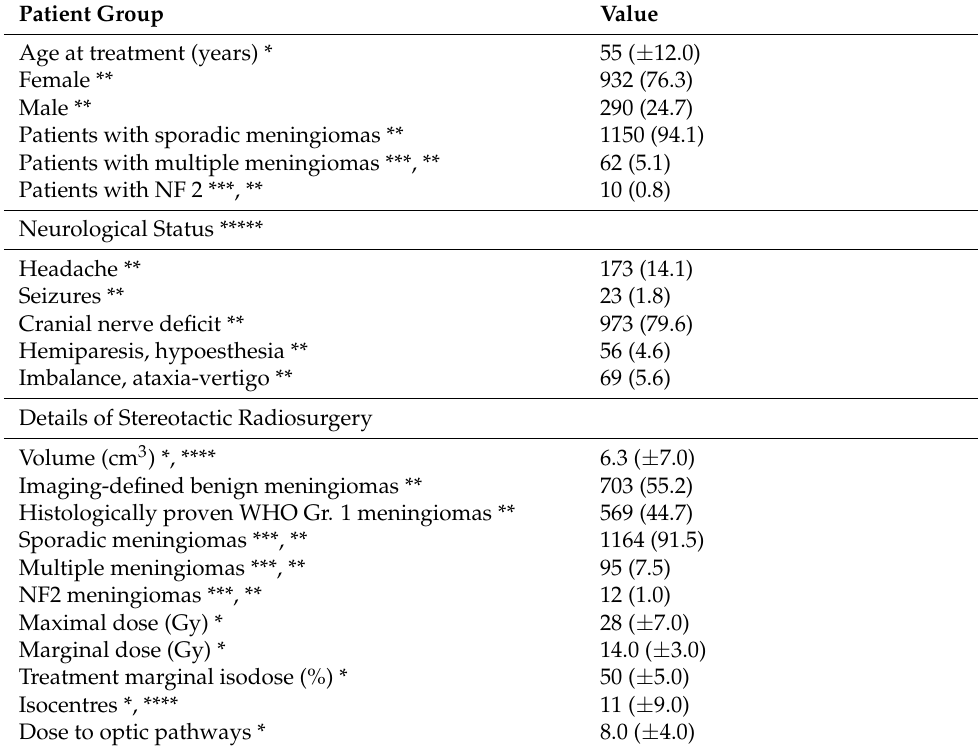
Table 1. Characteristics of 1222 patients treated with